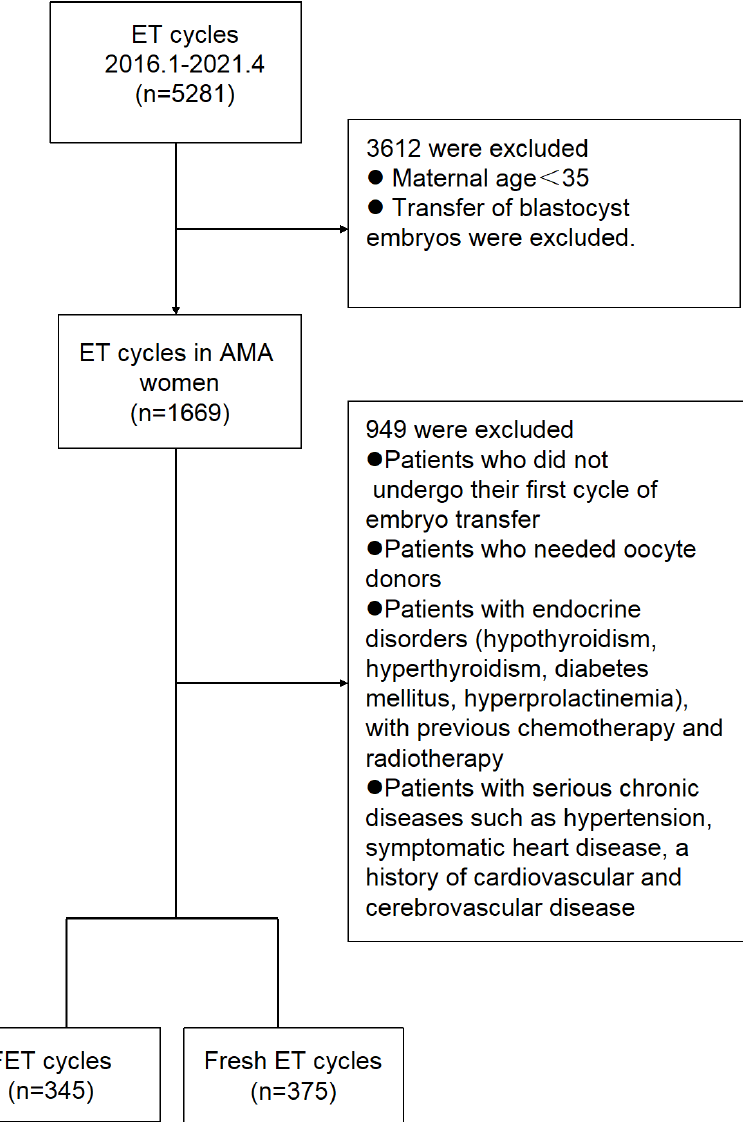
Figure 1. Enrollment and outcomes. Abbreviations: ET ― embryo transfer, AMA ― advanced maternal age, FET ⎯ frozen embryo transfer.